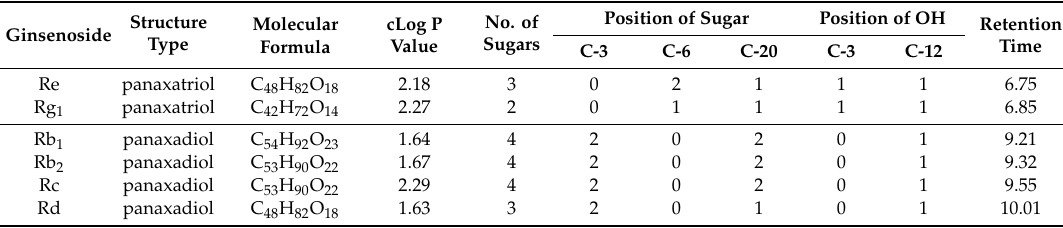
Table 2. Chemical structure and retention time of each ginsenoside. The cLog P values were calculated by the ChemDraw program 16